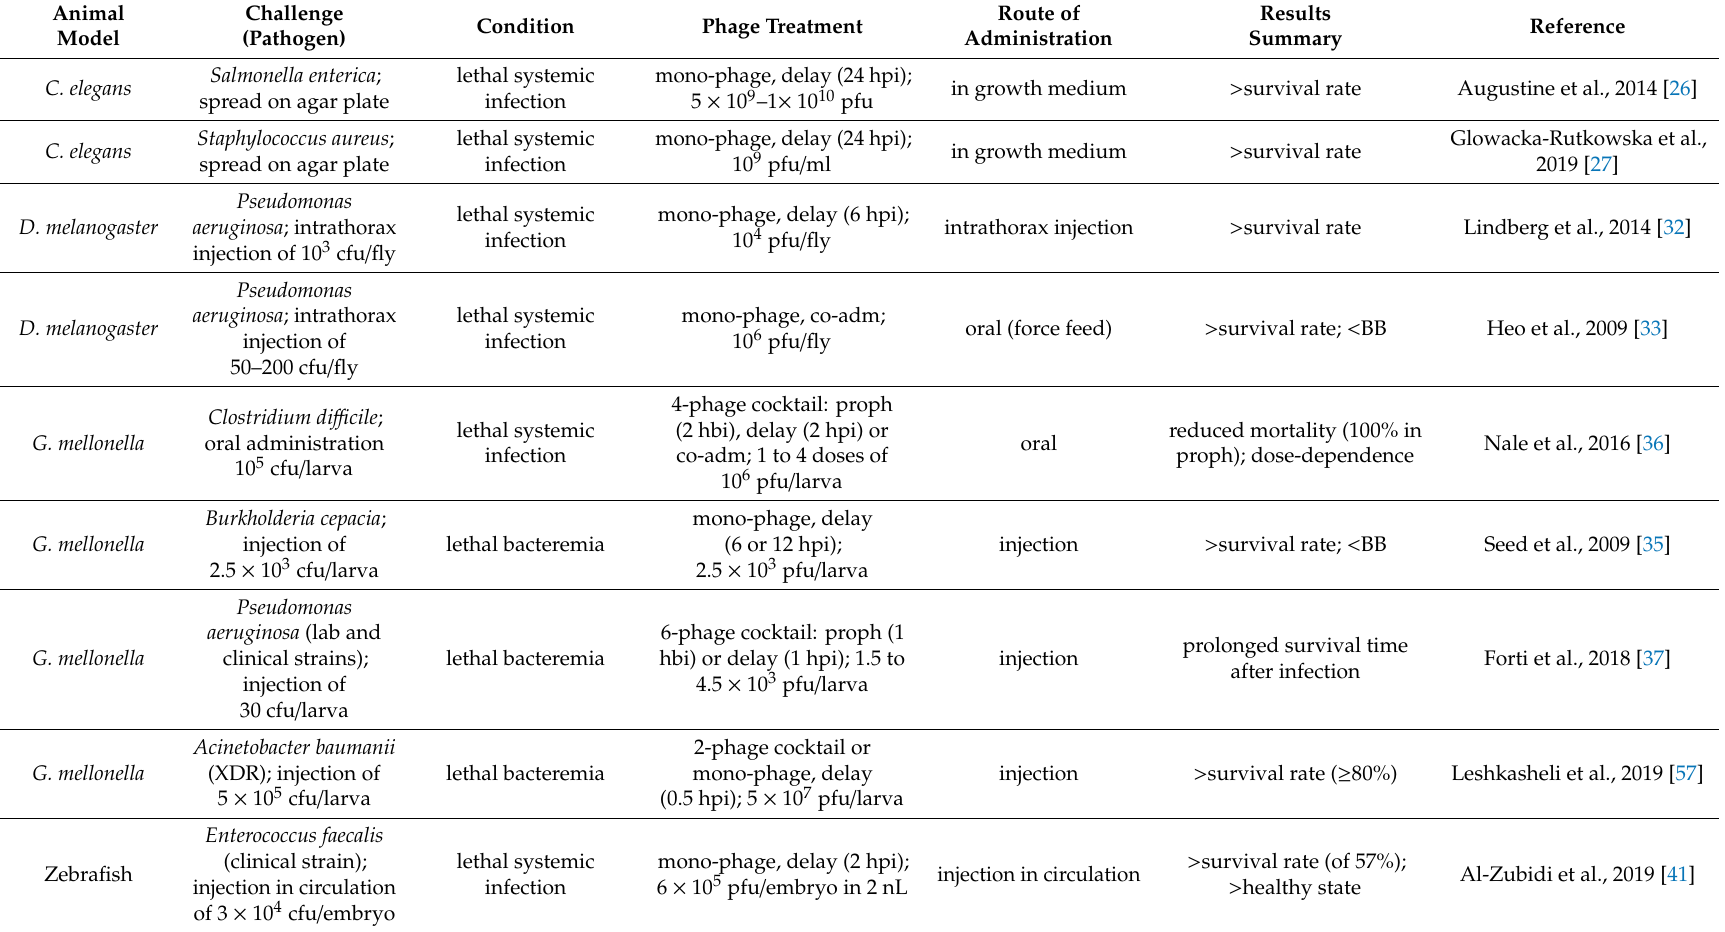
Table 1. Animal models of human phage therapy for common human